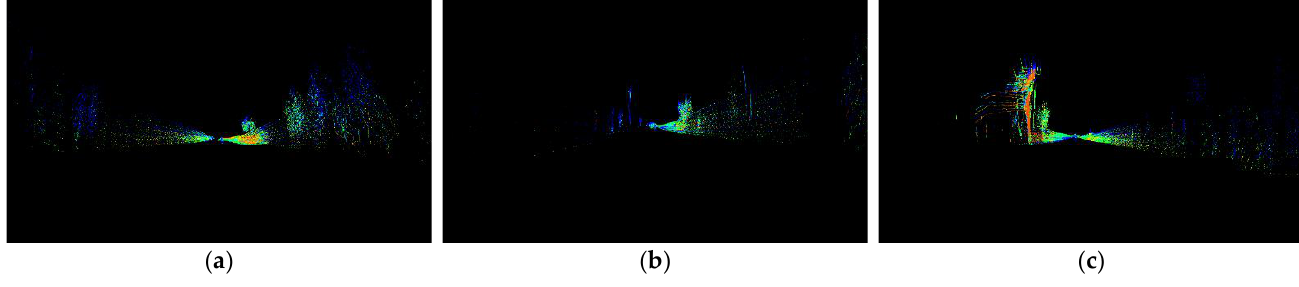
Figure 11. Point cloud image scene 7: Pond-counter-S16 ( a ) Picture 1, ( b ) Picture 2, ( c ) Picture 3.